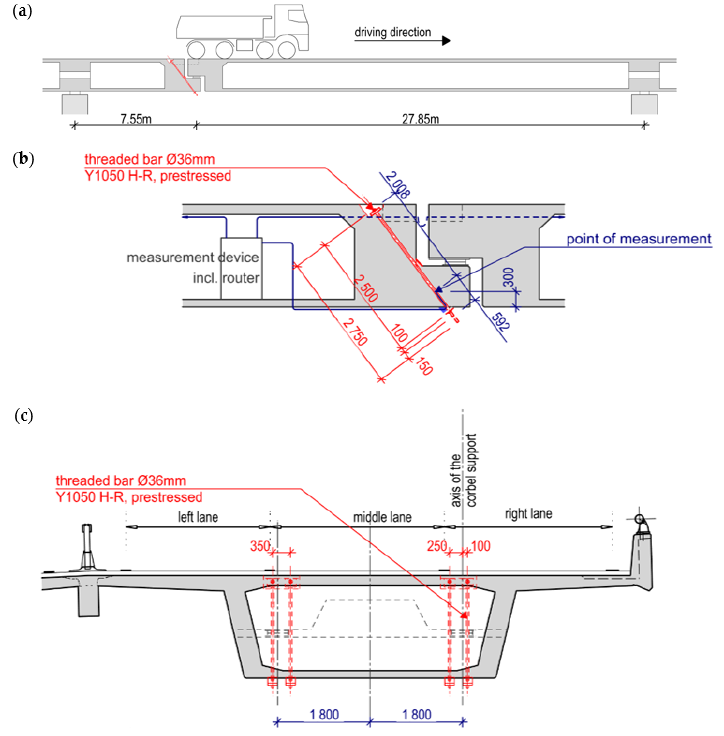
Figure 2. ( a ) One span which includes a Gerber hinge; ( b ) Reinforcement measure with a prestressed threaded rod; ( c ) cross-section of one direction of